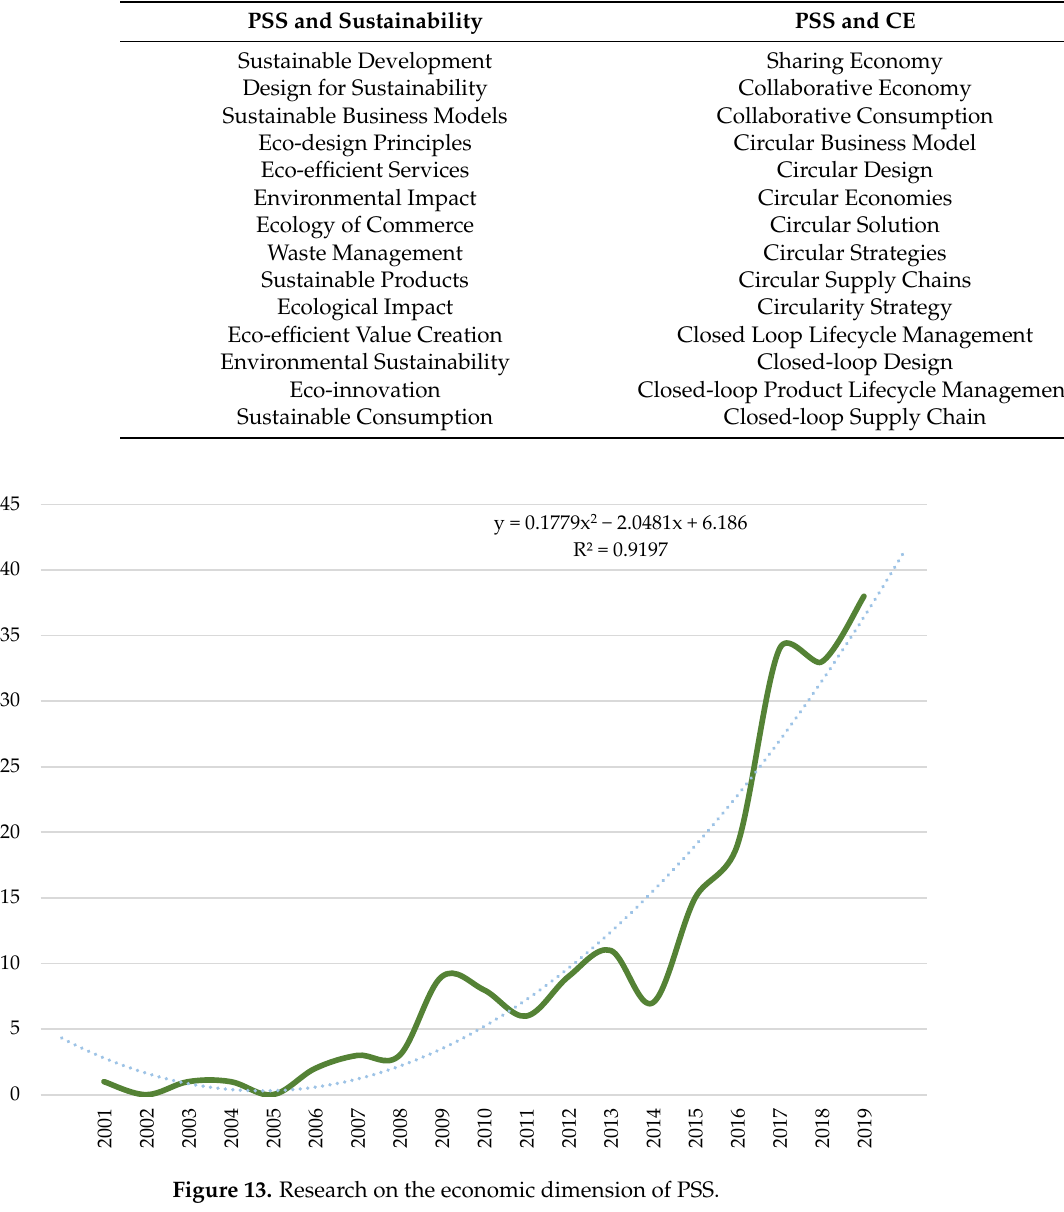
Table 14. Main keywords for sustainability and CE research.